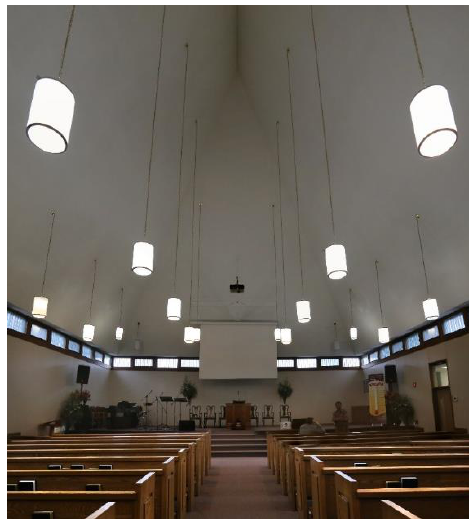
Figure 9. Ottawa East SDA